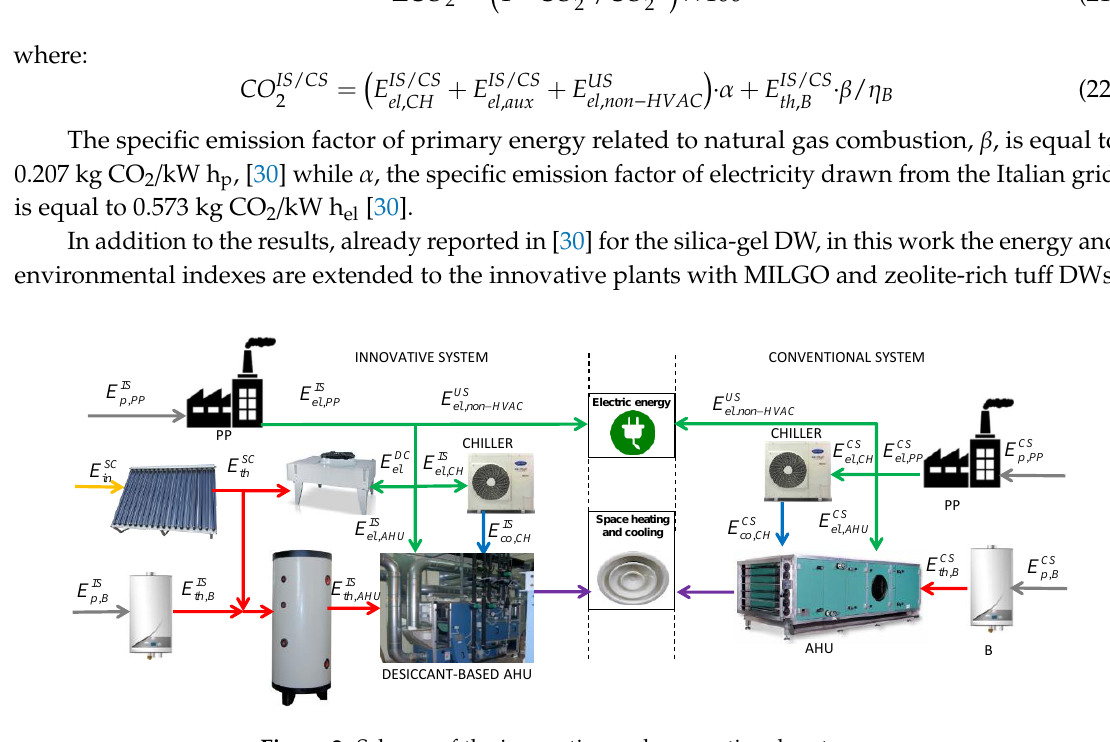
Figure 2. Scheme of the innovative and conventional systems.